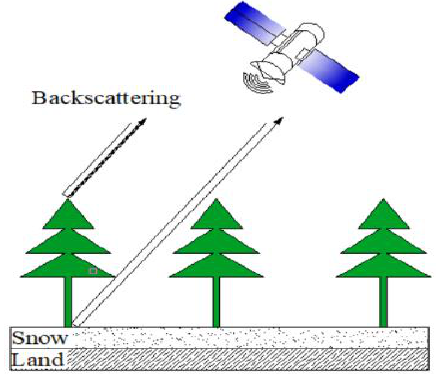
Figure 5. Scattering mechanism of a snow-covered area in a forest